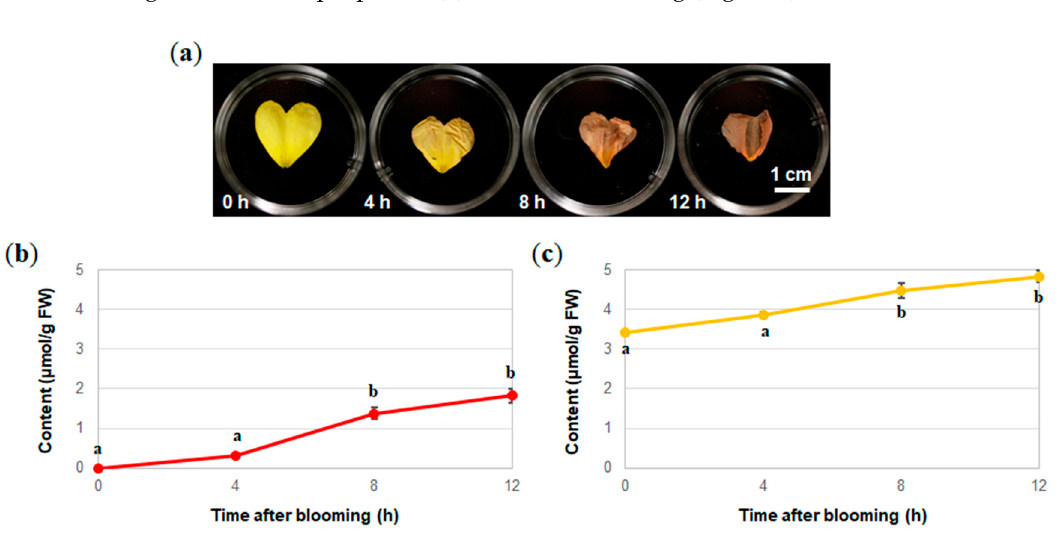
Figure 5. HPLC chromatograms of the extracts of the petals of O. laciniata . ( a ) Yellow petals at 0 h. ( b ) Orange petals at 12 h.